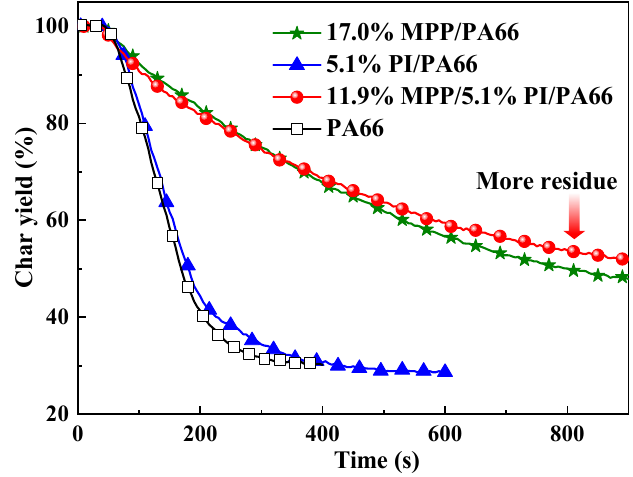
Figure 4. The mass loss curves of the flame-retardant PA66